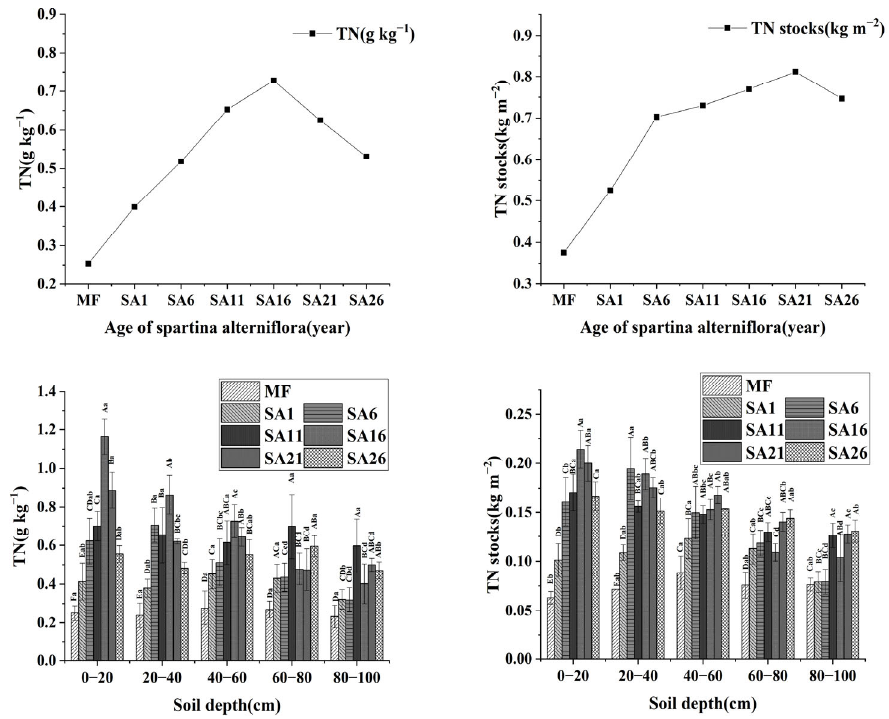
Figure 4. Distribution characteristics of soil TN content and storage at different stages of invasion. Different letters indicate significant differences between different years of invasion or soil depths. ( p <